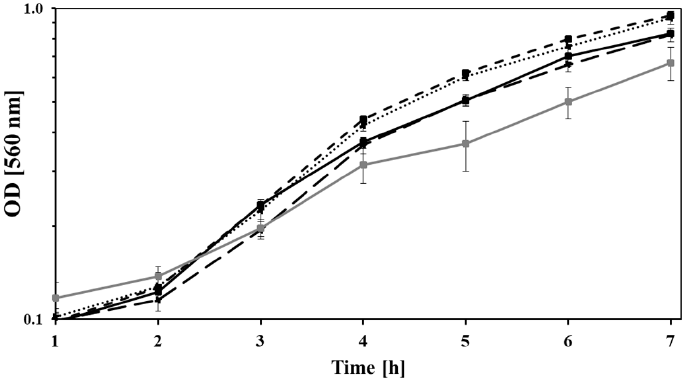
Figure 1. OD 560 during the growth of P. taiwanensis VLB120 (solid black line), P. taiwanensis GRC1 (dotted black line), GRC2 (long dashed black line), GRC3 (short dashed black line), and P. capeferrum TDA1 (solid gray line) on Na 2 -succinate (4 g/L). Error bars indicate the standard error of the mean (n = 3).